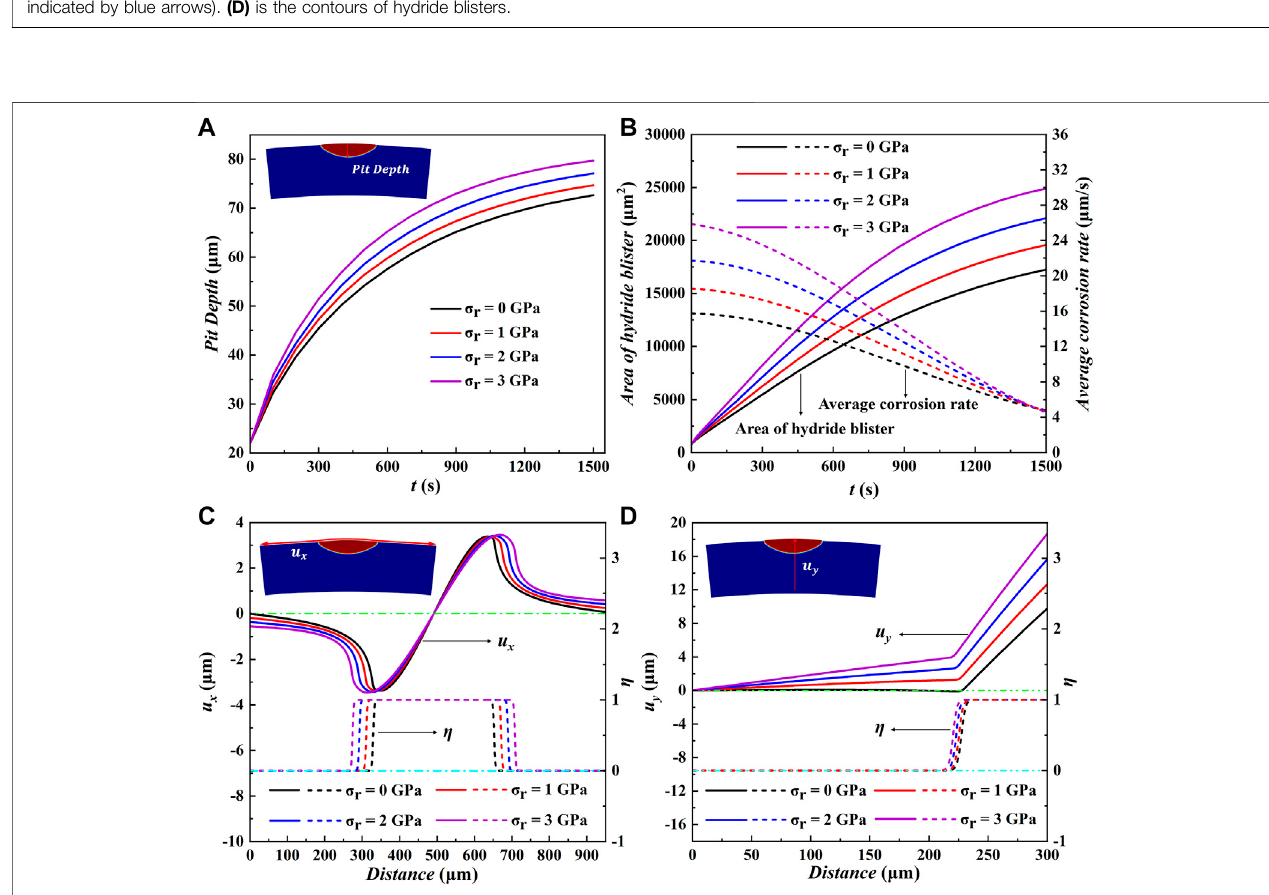
Frontiers in Materials |